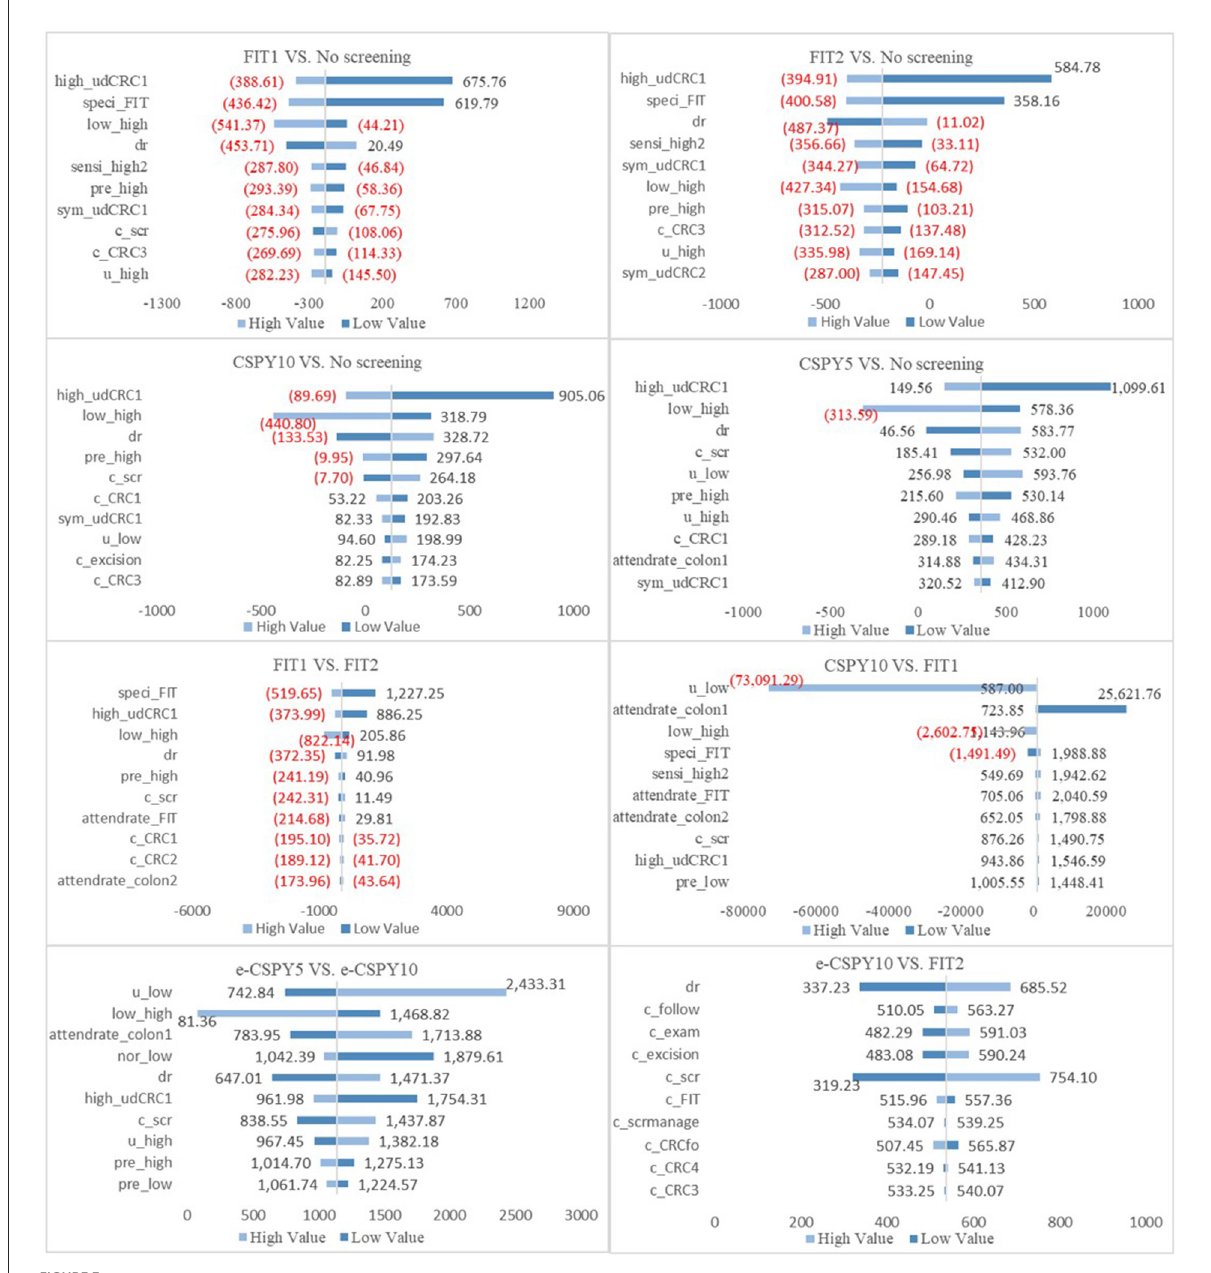
FIGURE3 The tornado figures of Deterministic Sensitivity Analysis. High, high-risk adenoma; low, low-risk adenoma; nor, normal; udCRC, undiagnosed colorectal cancer; CRC12/3/4, colorectal cancer I/II/III/IV; speci, specificity; sensi, sensitivity; dr, discount rate; c, cost; scr, screening; pre, prevalence rate; colon1, colonoscopy; colon2, colonoscopy following FIT; scrmanage, the management of the screening; E-CSPY10/5, electronic colonoscopy every 10/5 years; FIT1/2, annual/ biennial